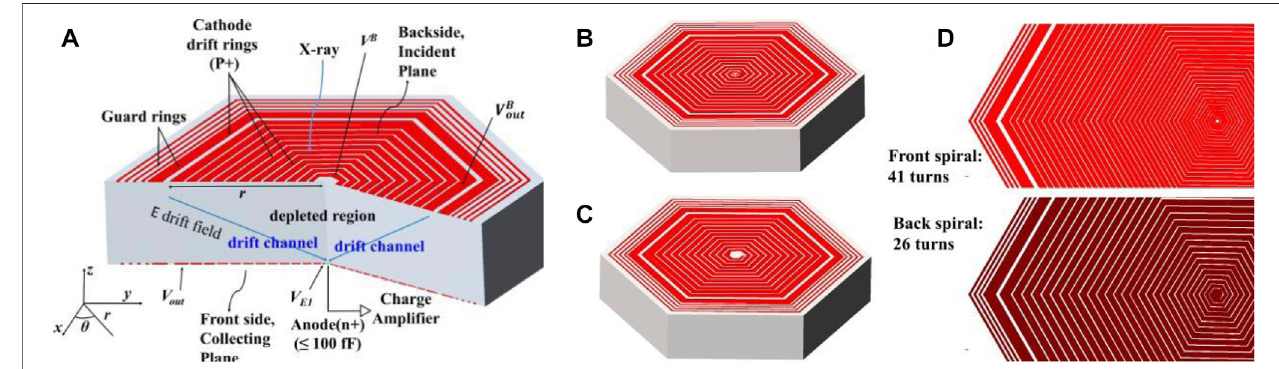
FIGURE 1 | Schematic of the 314 mm 2 DSSH-SDD. (A) The fi gure with all the parameters; (B) the front side and (C) the back side of the hexagonal double-sided spiral SDD; and (D) cut planes of the